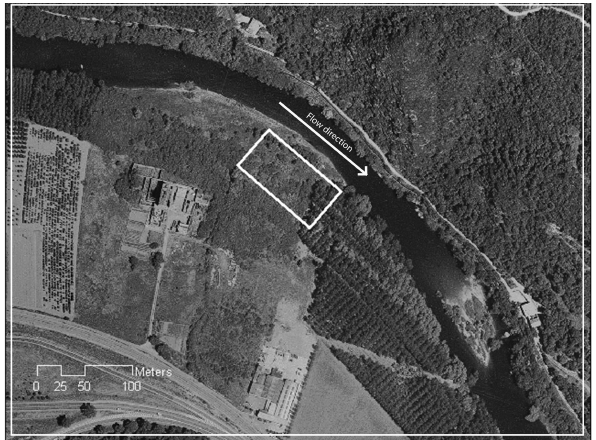
819 820 Figure 1. Ortophoto with the location of the modelled reach (large rectangle) and the detailed rectangle 821 Fig. 1. Ortophoto with the location of the modelled reach (large on the floodplain of the Ter River, near Sant Julià de Ramis (Girona, NE Spain). 822 rectangle) and the detailed rectangle on the floodplain of the Ter 823 River, near Sant Juli`a de Ramis (Girona, NE Spain).